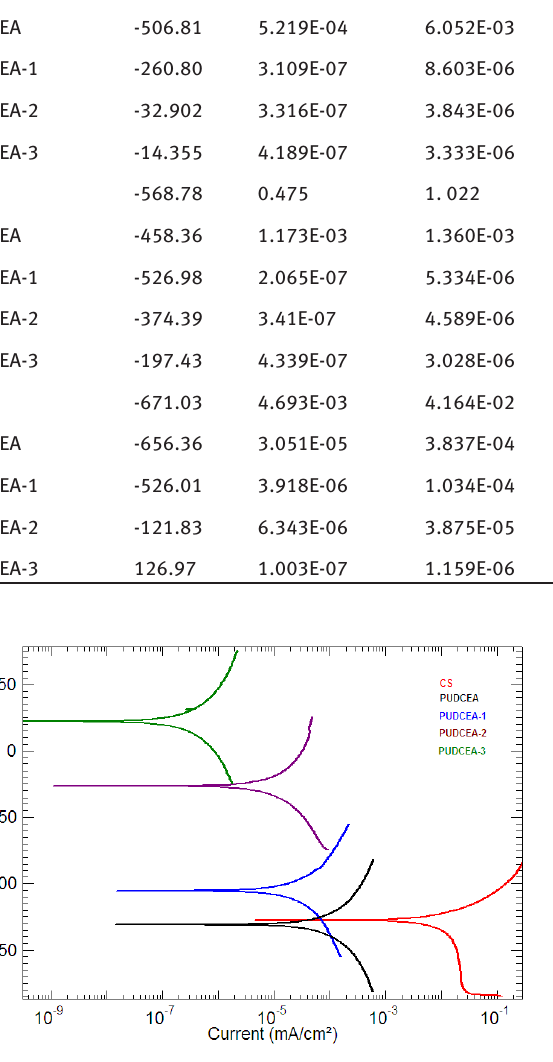
Figure 14: Tafel plot of bare CS, PUDCEA, PUDCEA-1, and PUDCEA- Figure 14. Tafelplot of bare CS, PUDCEA,PUDCEA-1, and PUDCEA-2andPUDCEA- 2andPUDCEA-3 in tap 3in tap water